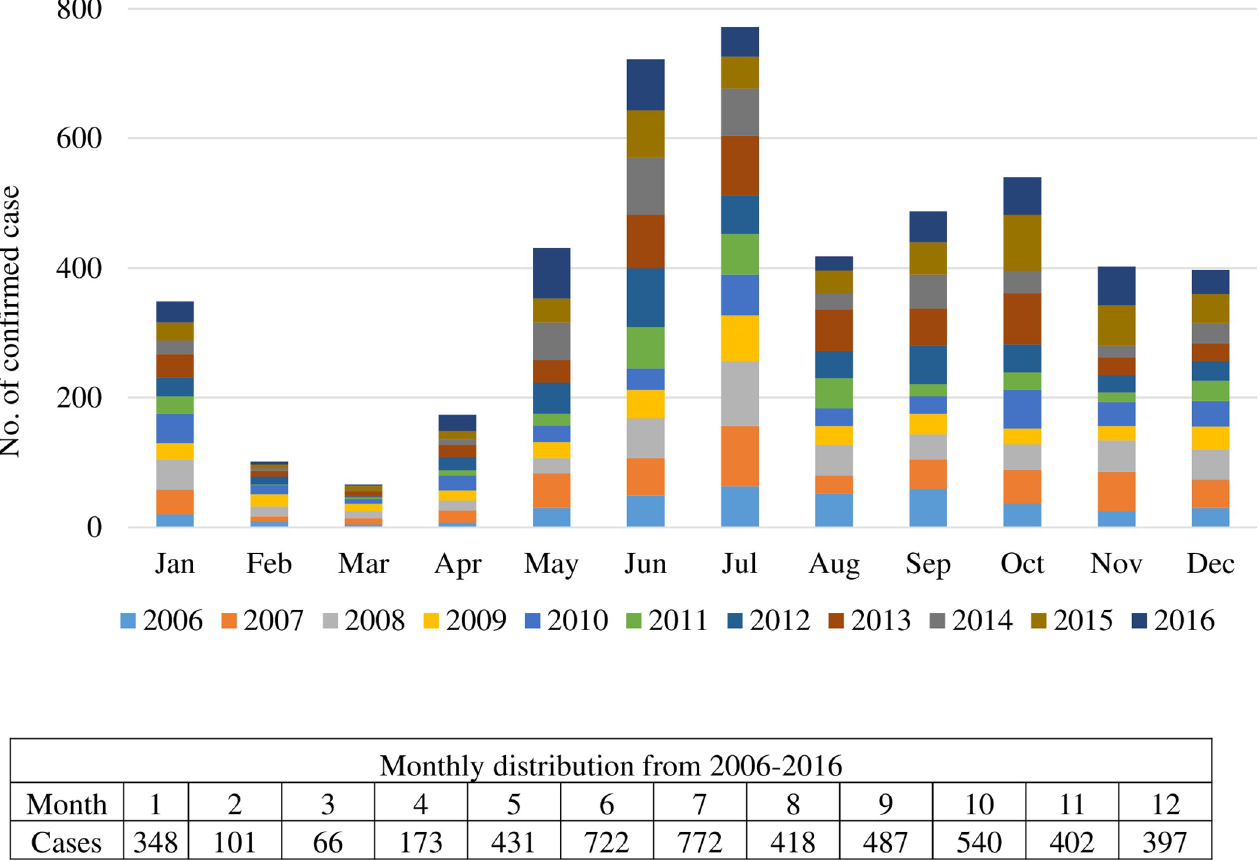
Fig 3. Monthly distribution of scrub typhus cases in Taiwan 2006–2016. Scrub typhus occurs year-round and peaks in the spring and fall